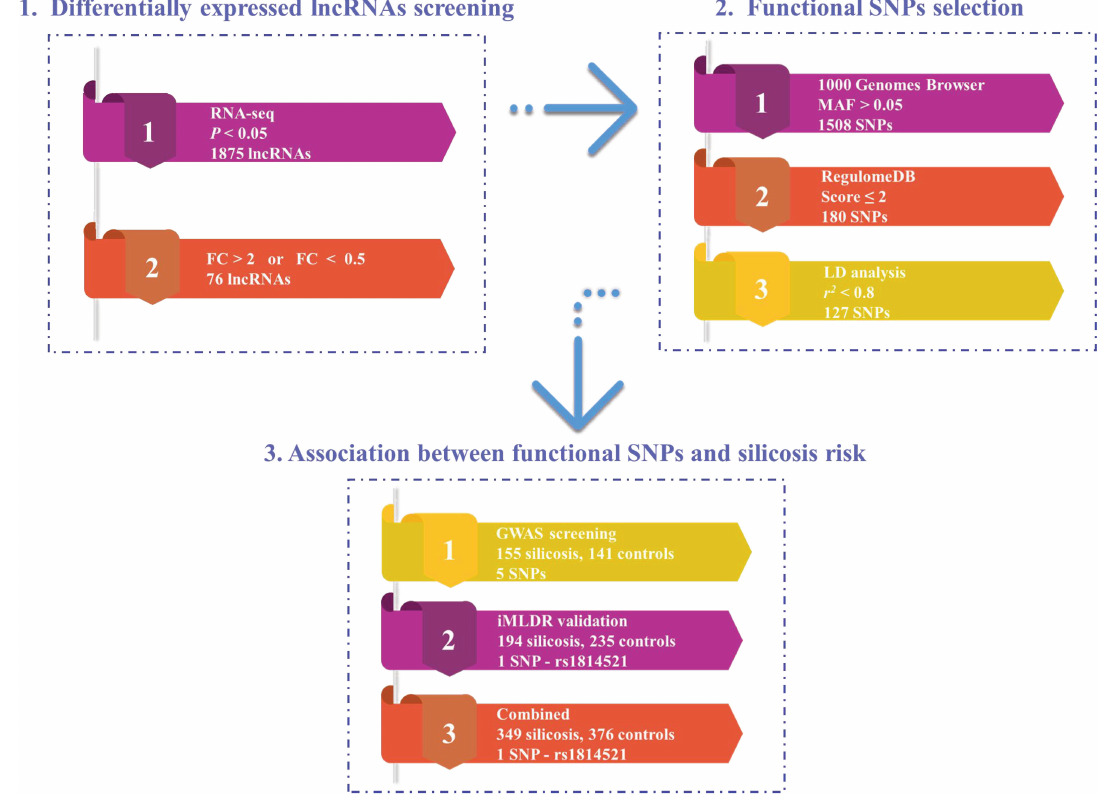
Fig. 1 Schematic representation of the multi-stage study design. RNA-seq, RNA sequencing; MAF, minor allele frequency; LD analysis, linkage disequilibrium